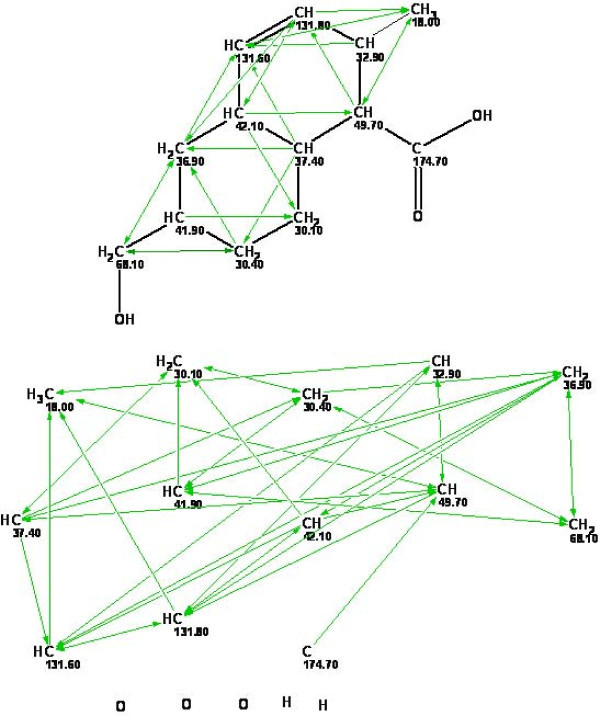
Example of a structure and its Molecular Connectivity Diagram of HMBC connectivities. In the structure, the HMBC connectivities are shown by arrows. It is seen that 131.6-18.0 and 36.9–131.8 connectivities are nonstandard (extending out above 3 bond correlations).